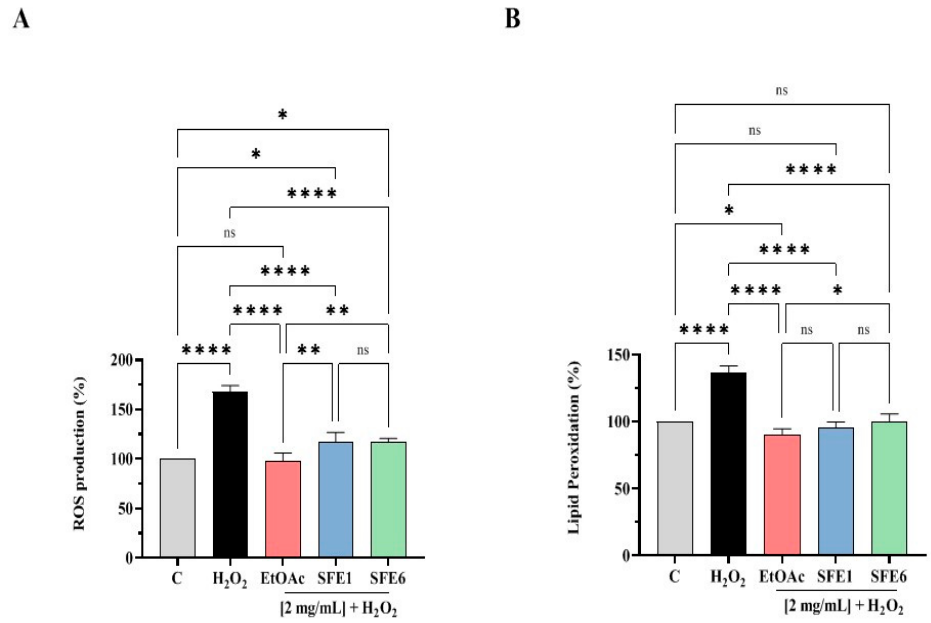
Figure 5. ( A ) Modulation of the intracellular ROS level H 2 0 2 ‐ induced after the pretreatment with EtOAc, SFE1 and SFE6. ( B ) Modulation of H 2 0 2 ‐ induced lipid peroxidation after the pretreatment with EtOAc, SFE1 and SFE6. Data represent the mean ± s.d. of six independent